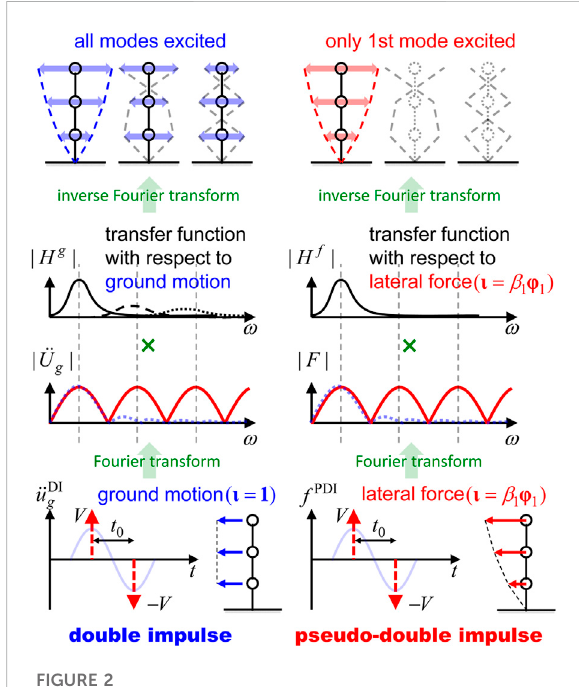
FIGURE 2 Double impulse (DI) and pseudo-double impulse